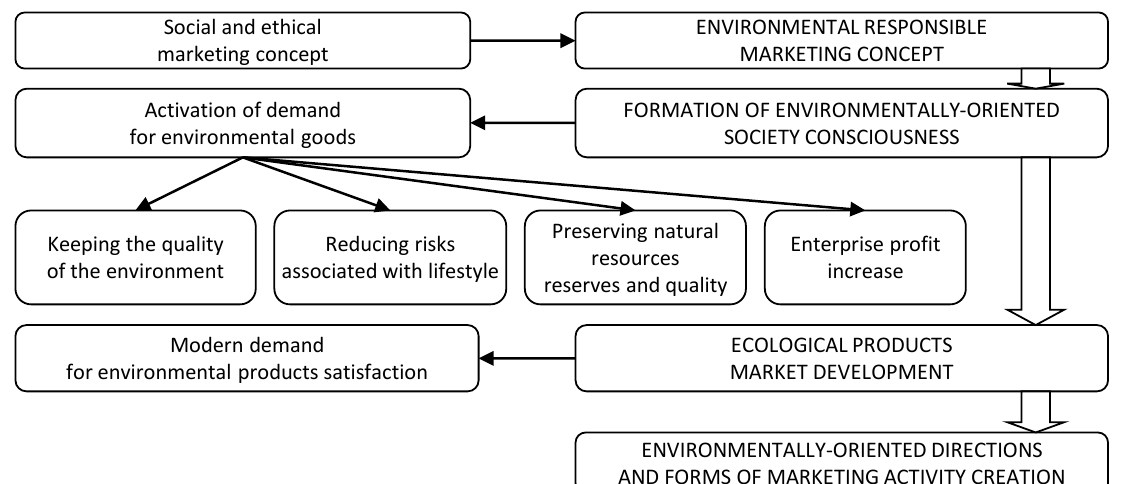
Figure 3. Formation of ecologically-oriented behavior of economic